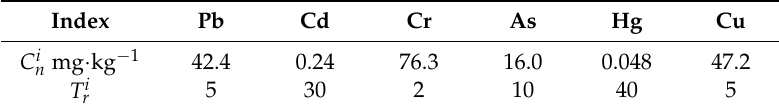
(Table 3) [20]; C i —the measured value concentration of heavy metals ( i ) in the soil’s surface; and s C i —the reference background content of Yunnan Province soil (Table 3) [21]. n Table 3. Reference C i n and toxic coefficient T i r of different heavy